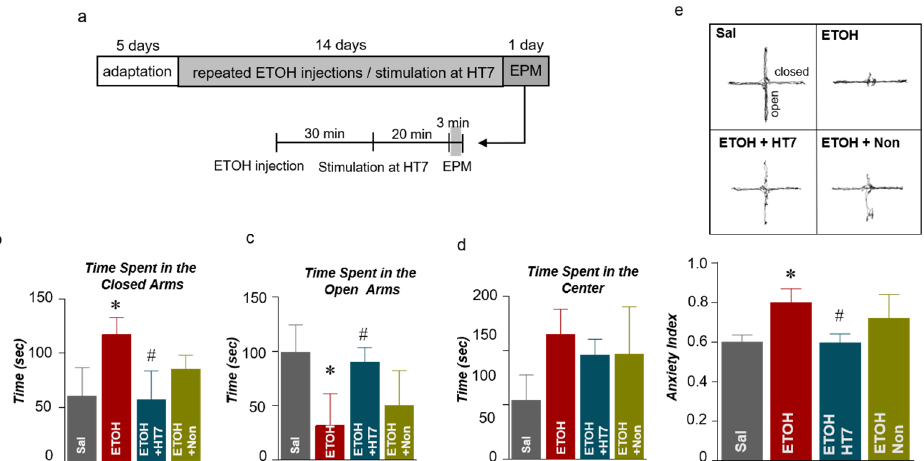
Figure 3. Schematic showing the acupuncture stimulation and elevated plus maze (EPM) test schedule ( a ). Quantification of the number of entries into the closed arms ( b ), open arms ( c ), and center ( d ) of the EPM (n = 10–11 rats per group). Anxiety indexes in the EPM ( e ). The data were analyzed using repeated measures ANOVA followed by Tukey’s test. * p < 0.05 compared with the Sal group and # p < 0.05 compared with the ETOH group. Values are presented as means ± SEM.